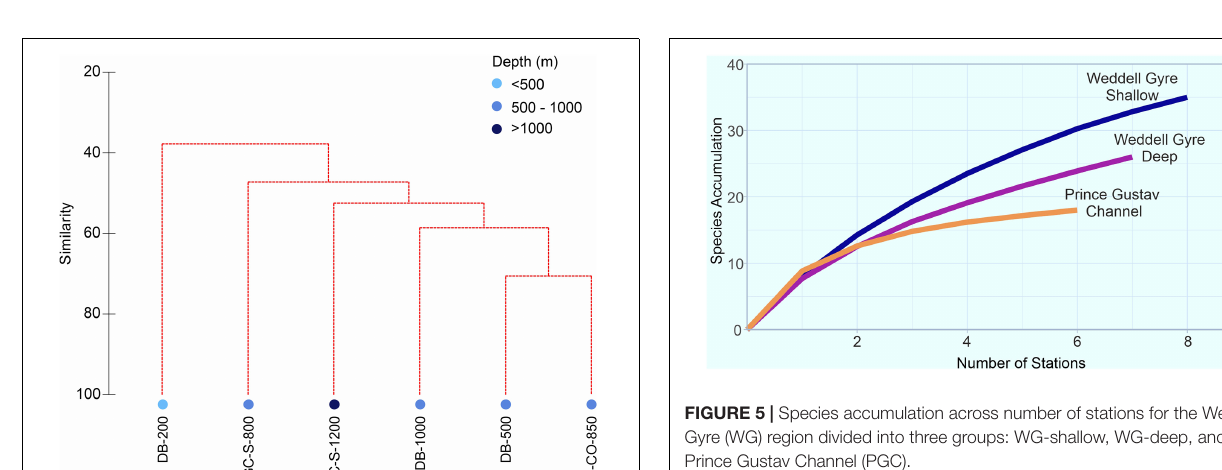
FIGURE 3 | Contributions of functional traits to molluscan relative abundances by station (DB, Duse Bay; PGC, Prince Gustav Channel; S, South; CO, Cape Obelisk). (A) Development type. (B) Mobility type. (C) Lifestyle. (D) Reproduction Mode.